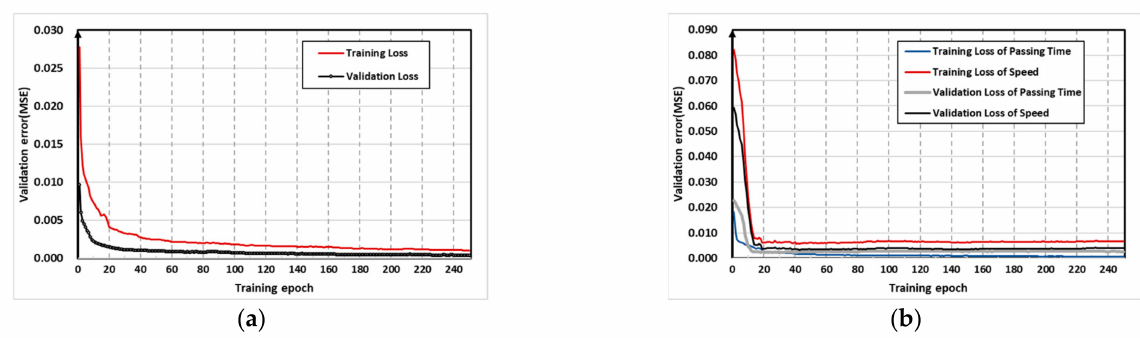
Figure 13. The training epoch: ( a ) the total training process; ( b ) the passing time and speed training process